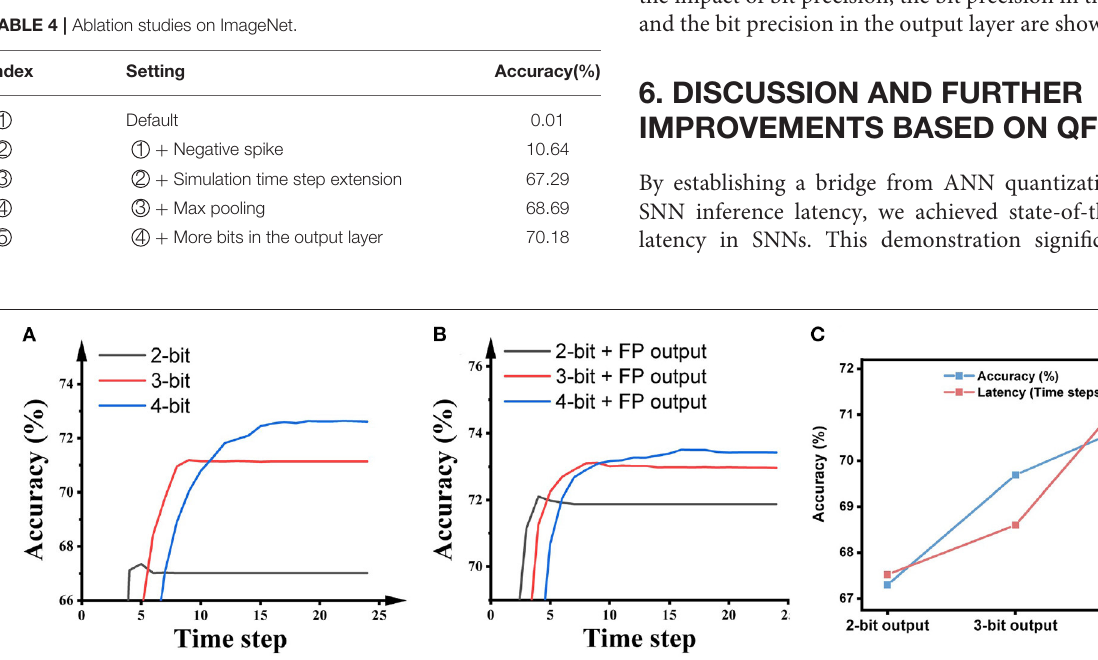
Frontiers in Neuroscience |